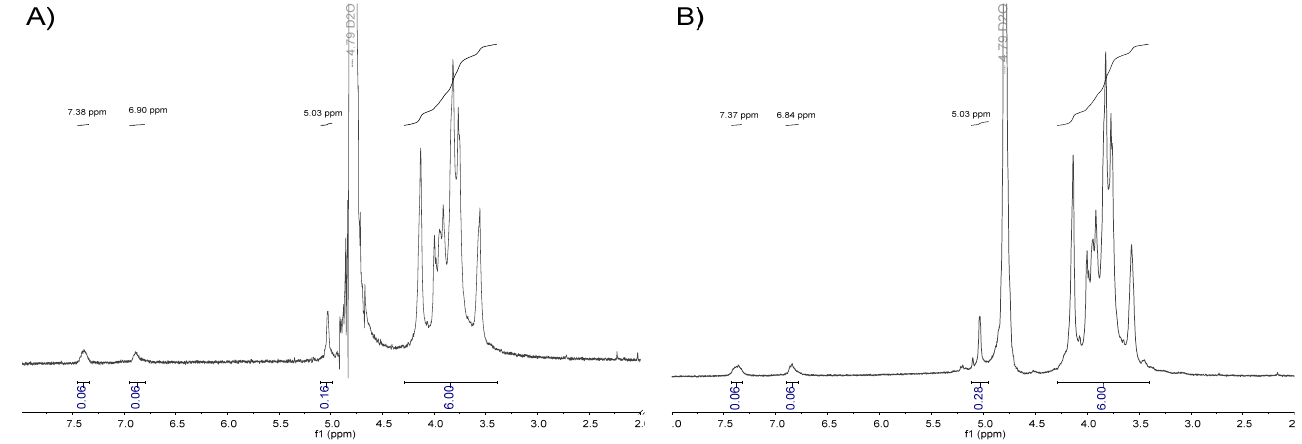
Figure 5. ( A ) 1 H-NMR of GM HCl/ox/ATP in D 2 O. ( B ) 1 H-NMR of GM Enz/ox/ATP in D 2 O.